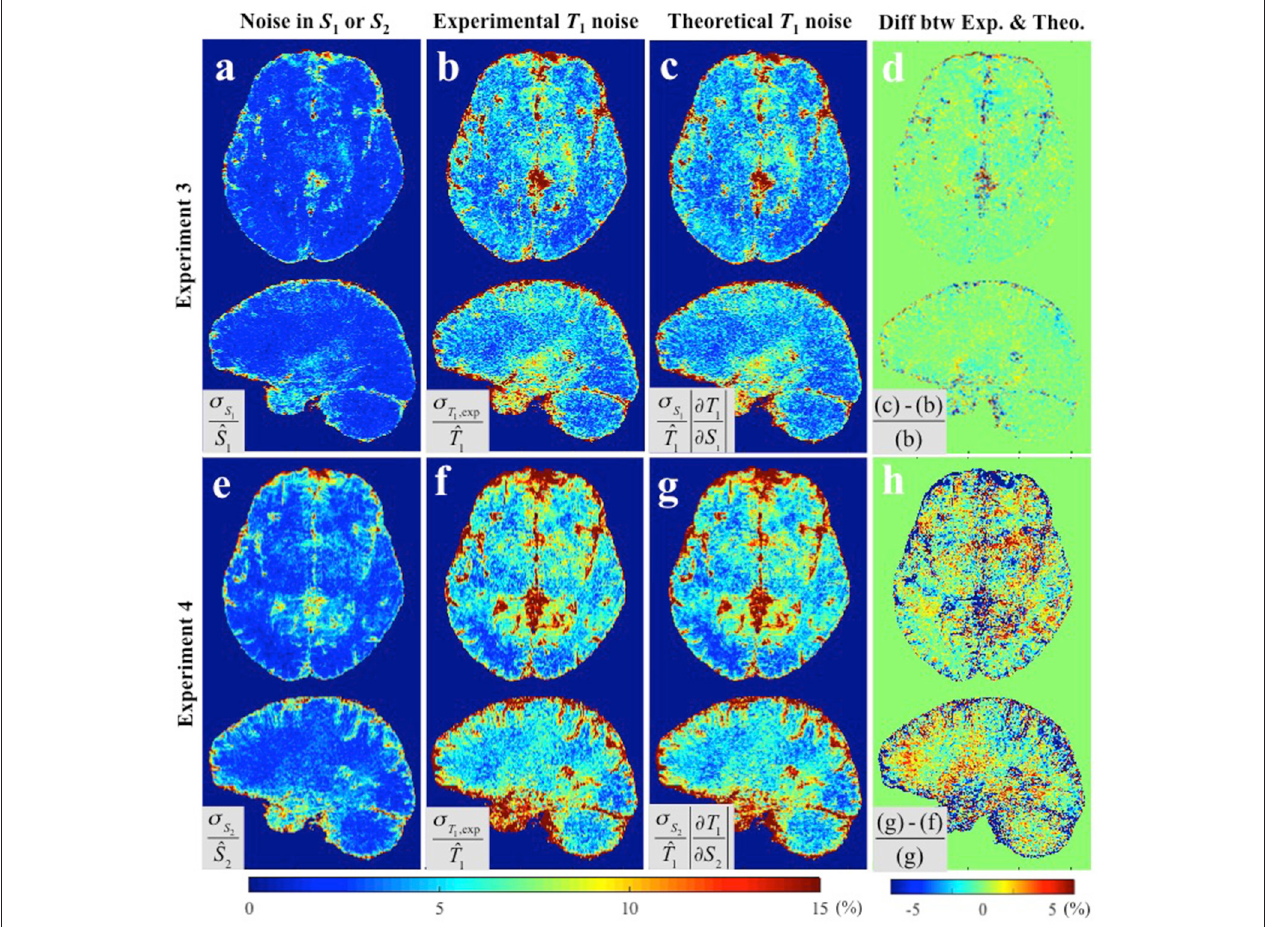
FIGURE 4 | CV maps (a,e) of the input images in Experiments 3 and 4 ( S 1 and S 2 respectively), (b,f) the experimentally obtained variability in the estimated T 1 maps using Experimental variance evaluation , and (c,g) the theoretically-predicted T 1 noise from the first term in Equation (5), i.e., 100 · σ S / ˆ T 1 respectively ( Theoretical variance evaluation ). (d) The percentage difference between (b) and (c) . (h) The percentage difference between (f) and (g) . Results are shown separately for Experiment 3 (a–d) and Experiment 4 (d–h) . All CV maps shown were calculated by the equations shown in the corresponding gray boxes multiplied by 100. ˆ S 1 , ˆ S 2 , and ˆ T 1 in gray boxes denote the average values of six S 1 , S 2 , and corresponding T 1 maps